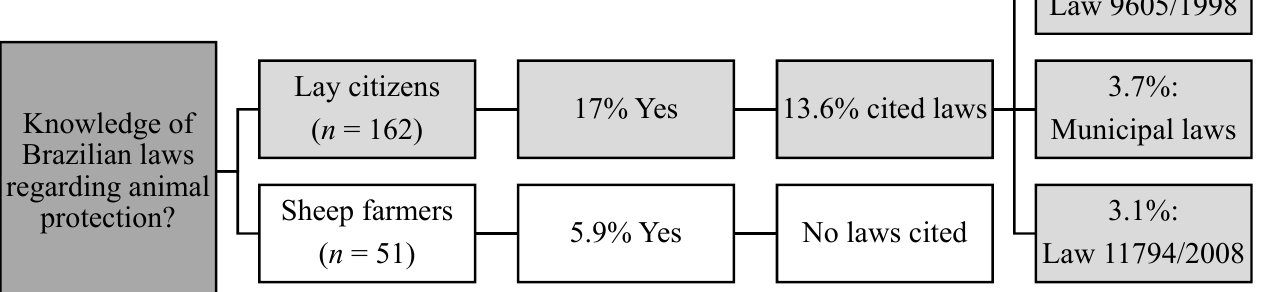
Figure 3. Knowledge of Brazilian laws regarding animal protection of citizens and sheep farmers in the State of Rio Grande do Sul, Brazil, from September to December 2017; Law 9605/1998 lists animal maltreatment as crime and Law 11794/2008 regulates the use of animals in research.